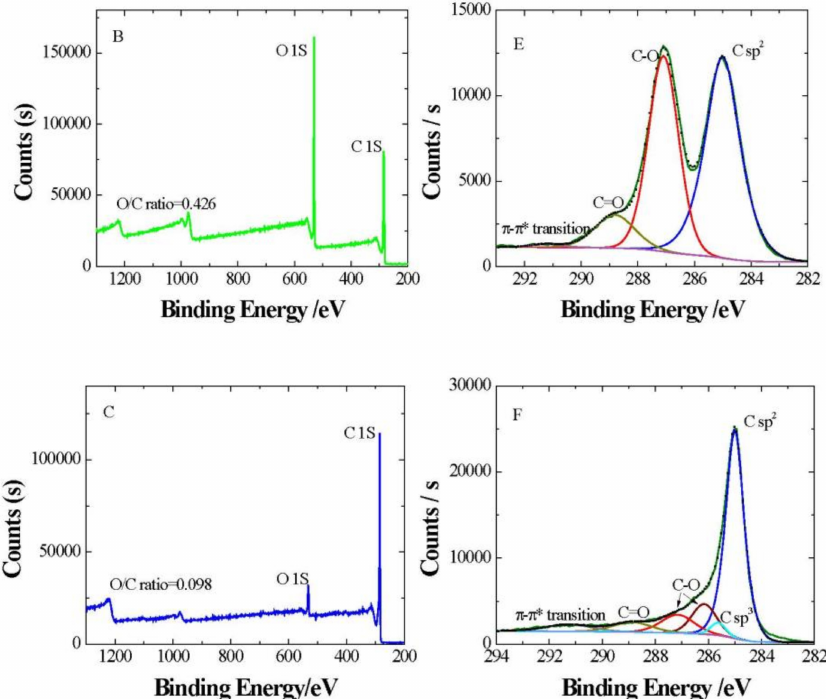
Figure 2. Full XPS spectra of ( A ) xGnP, ( B ) xGOnP, and ( C ) r-xGOnP nanosheets. High-resolution C1s spectra of ( D ) xGnP, ( E ) xGOnP, and ( F ) r-xGOnP nanosheets.